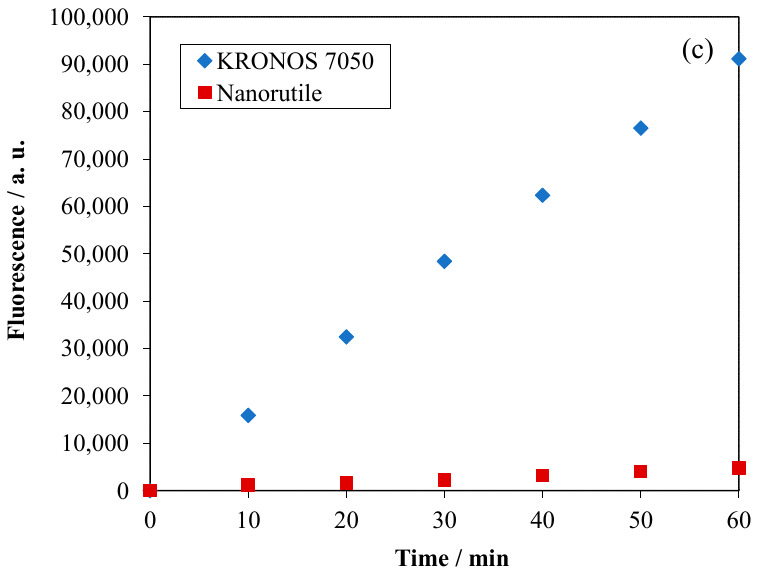
Figure 3. OH radical formation during irradiation of UV light on the prepared titania samples under ( a ) argon, ( b ) hydrogen, and ( c ) commercial.